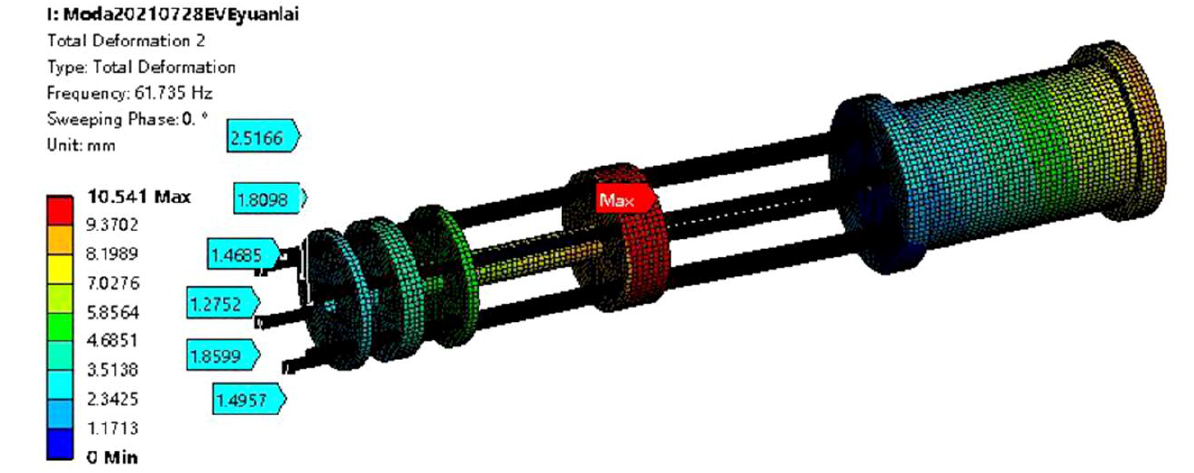
Figure 23. L value of 225 mm in M134.